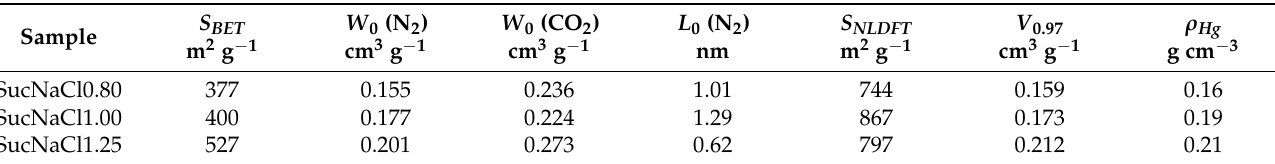
Figure 2. ( A ) Nitrogen adsorption isotherms at − 196 °C, and ( B ) carbon dioxide adsorption isotherms at 0 °C for samples SucNaCl0.80 ( □ ), SucNaCl1.00 ( ○ ) and SucNaCl1.25 ( △ ). Table 1. Porosity characteristics of the materials deduced from gas adsorption experiments, and bulk density from mercury intrusion porosimetry.